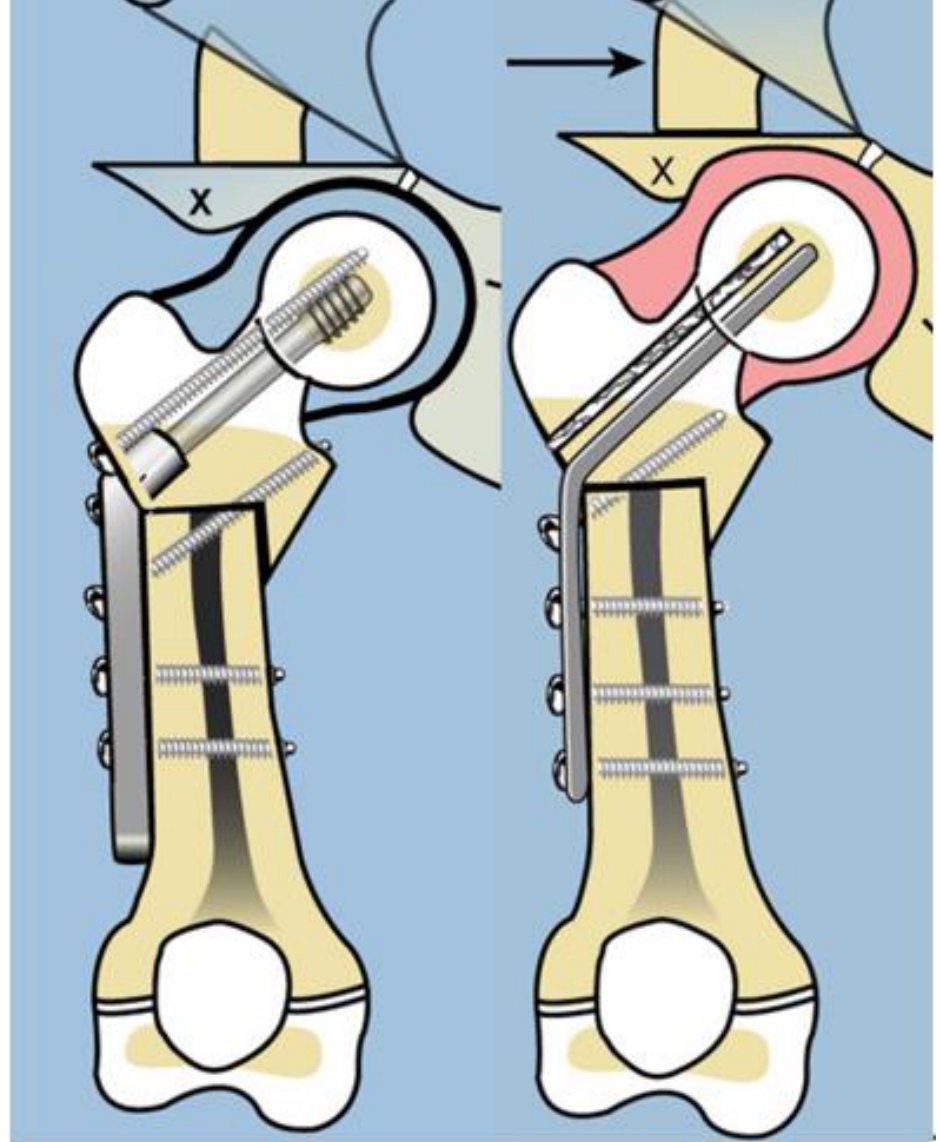
Figure 4. Illustration after SUPERhip procedure using a fixed angle device for fixation; sliding hip screw with additional rotation control second screw (left), and blade plate (right). Note on the right side there is a drill hole made for insertion of BMP2 superior to the blade.